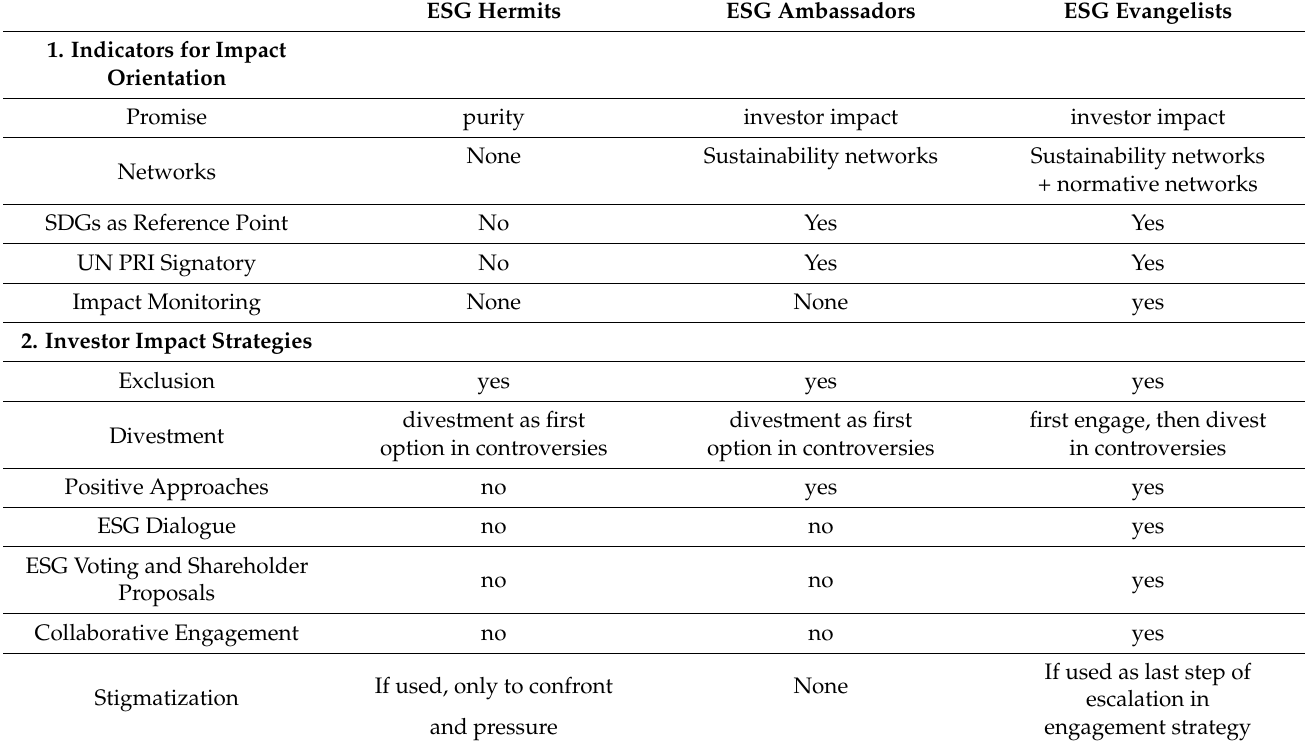
Table 1. Contrasting the three main types of fund providers. ESG Hermits ESG